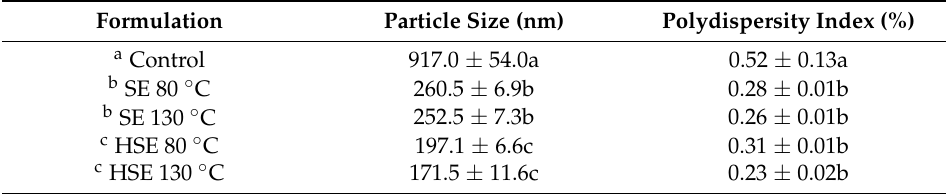
Table 2. Particle size analysis of the supernatant of the suspension for the soybean-polymer composite.